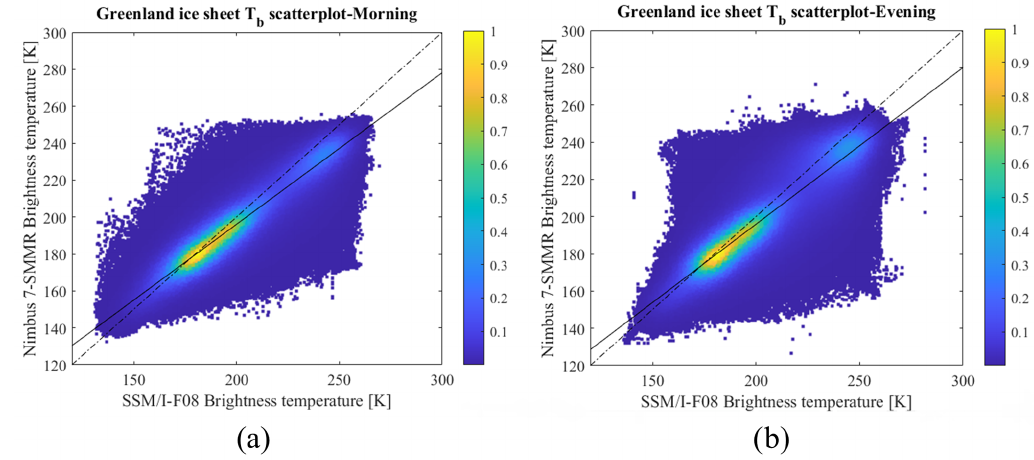
Figure 3. Density scatterplots of SMMR and SSM/I-F08 T b data sensed during the overlap period (9 July–20 August 1987) of the two sensors over the Greenland ice sheet for (a) morning and (b) evening passes. The solid black lines show the linear fitting, and the dashed black lines show the 1 : 1 line. The color palette indicates the relative